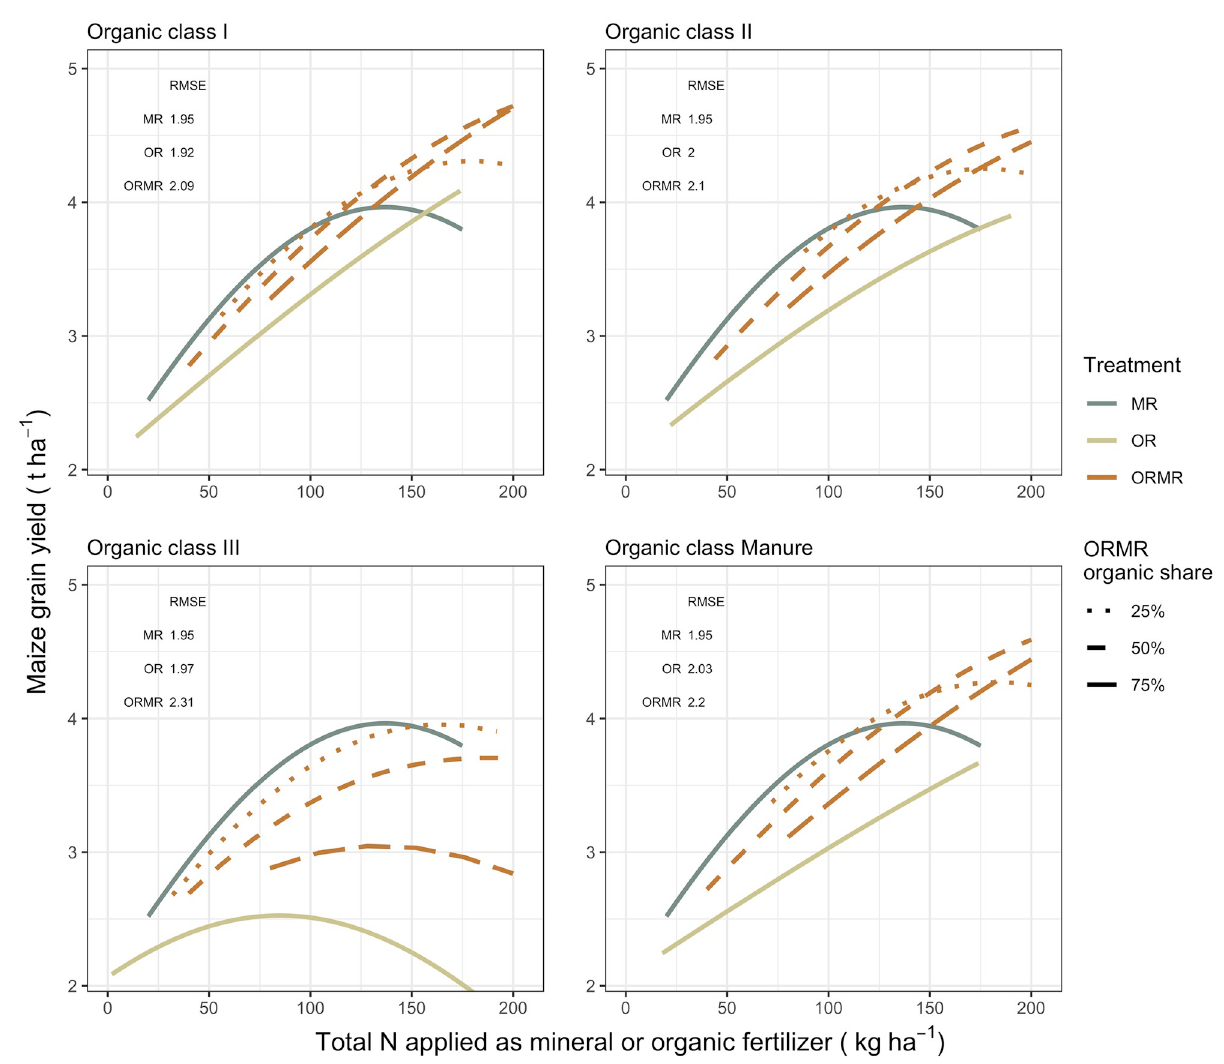
Fig 6. Model predicted maize grain yield values were plotted for the available total N rate, within a range of 0-200 (kg ha -1 ), applied as mineral or organic fertilizer, separately for each organic class and ORMR with three different organic N rate proportions. The root mean square error (RMSE, in t ha -1 ) is given for the different predicted yields from treatments with the respective organic